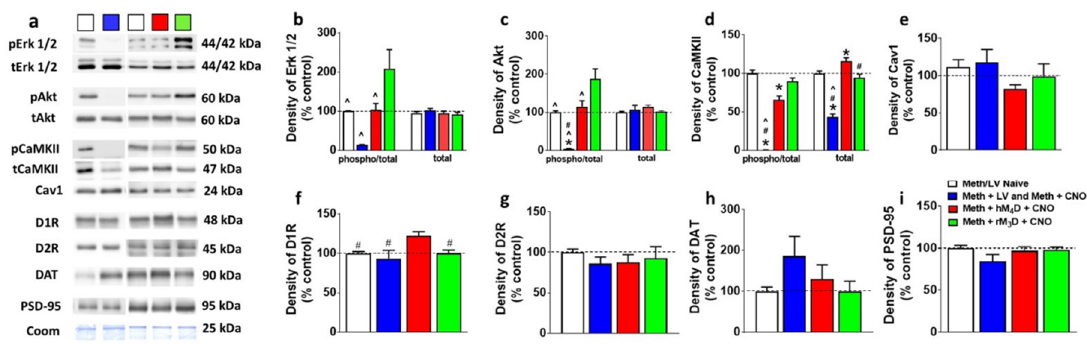
Figure 4. ( a ) Representative immunoblots of the various proteins used for Western blotting analysis. The experimental groups are indicated as colored square boxes for each lane (Meth/LV naïve control, white square; Meth + LV and Meth + CNO groups combined, blue square; Meth + hM4D + CNO, red square; Meth + rM3D + CNO, green square. Molecular masses (kilodaltons, kDa) are indicated adjacent to each representative blot. Corresponding Coomassie staining (Coom) of the membrane is shown as loading control. ( b – i ) Quantitative analysis of the proteins. * p < 0.05 vs. controls, # p < 0.05 vs. hM 4 D animals, ^ p < 0.05 vs. rM 3 D animals by one-way ANOVA followed by posthoc analysis. n = 5–10 in each group. Data is represented as mean ± SEM.